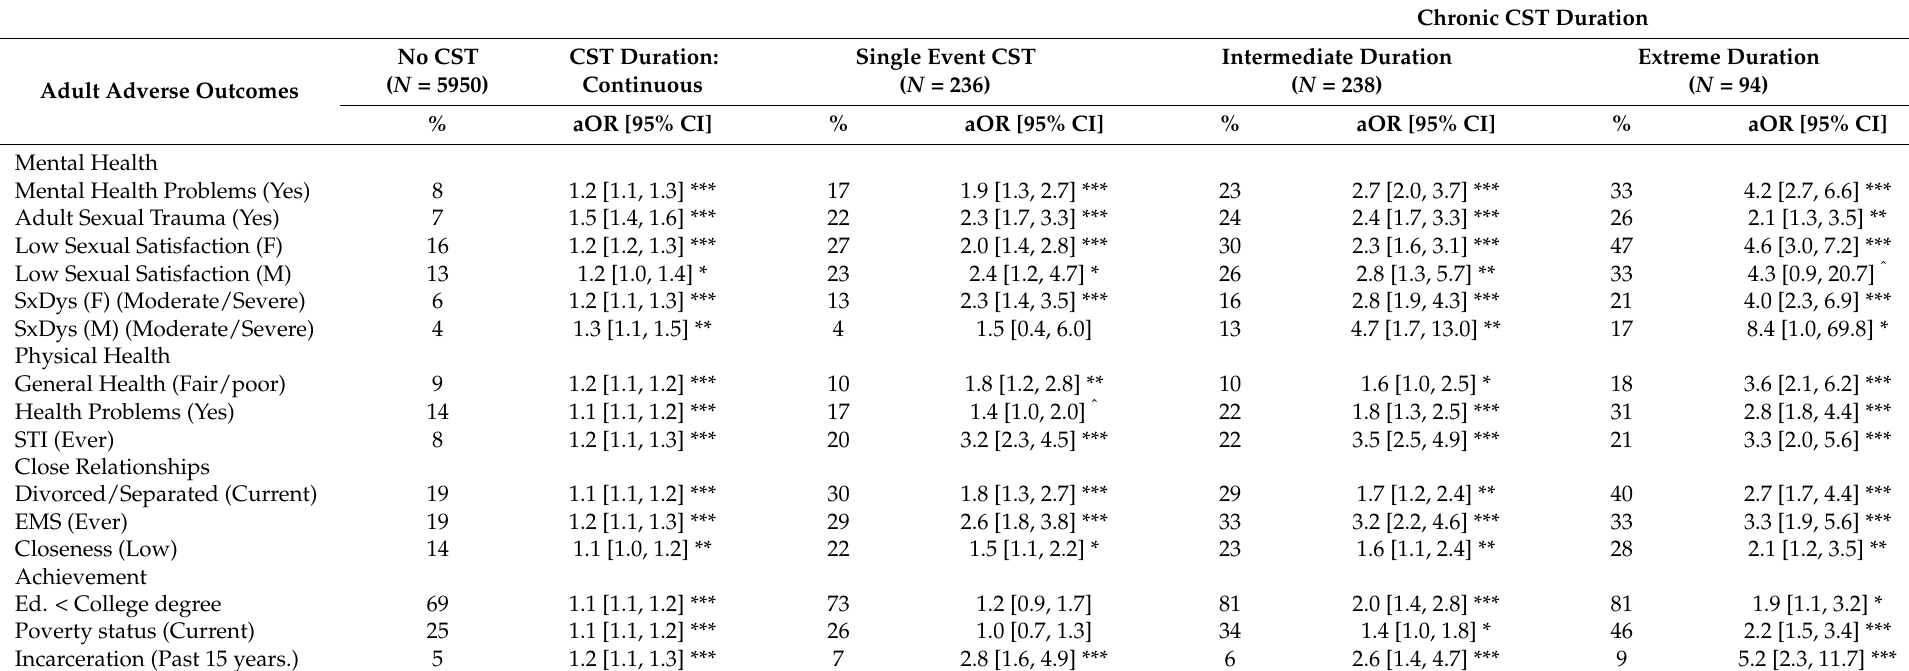
Table 4. Adverse outcomes by CST duration (National Sexual Health Survey, 1996) †